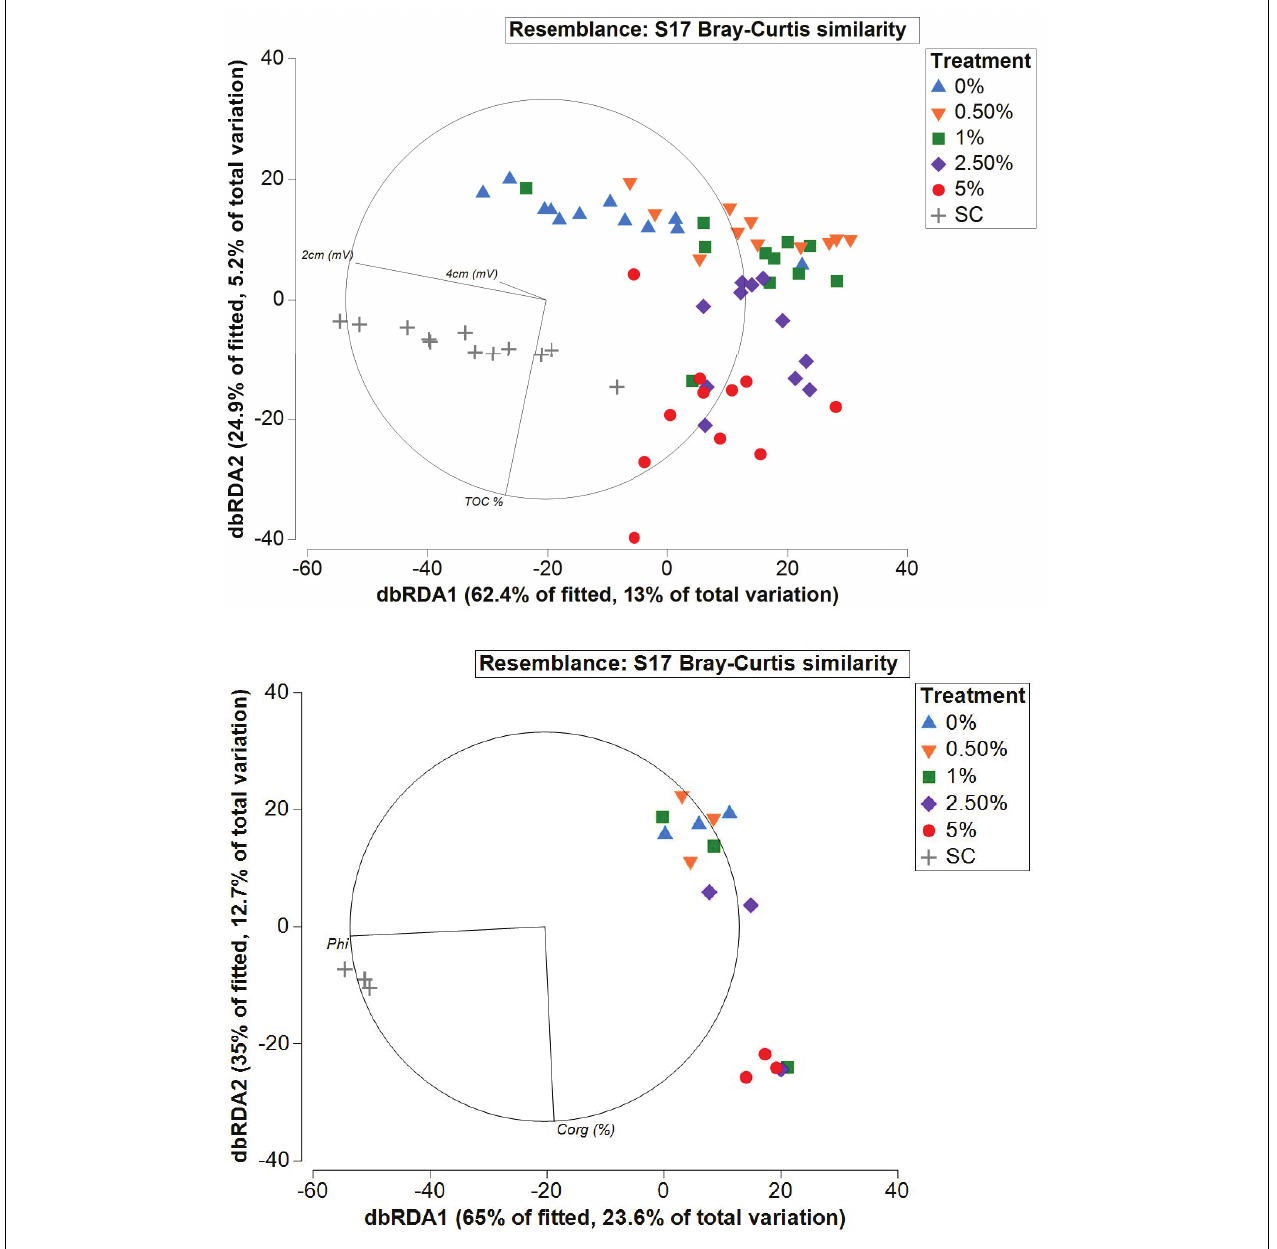
FIGURE 9 | dbRDA plots showing relationship between macrobenthic community structure in the 45 days – 365 days dataset with redox potential at 2 cm (2 cm [mV], r 2 = 0.11) and 4 cm (4 cm [mV], r 2 = 0.04) and organic carbon ( r 2 = 0.06) (top panel) , and 365 days dataset with median grain size (Phi, r 2 = 0.23) and organic carbon ( r 2 = 0.13) (bottom panel)